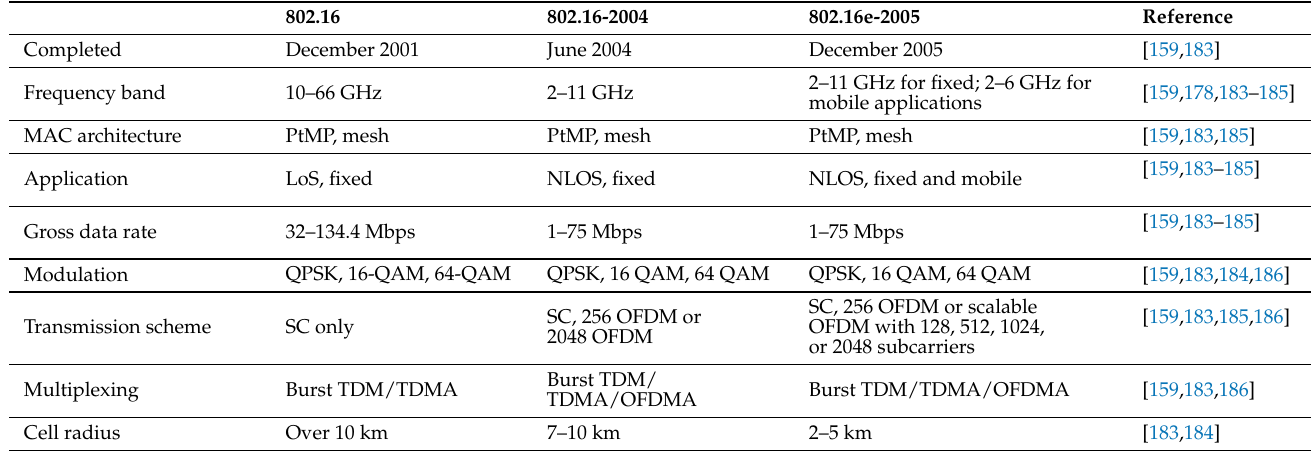
Table 5. Basic data on IEEE 802.16